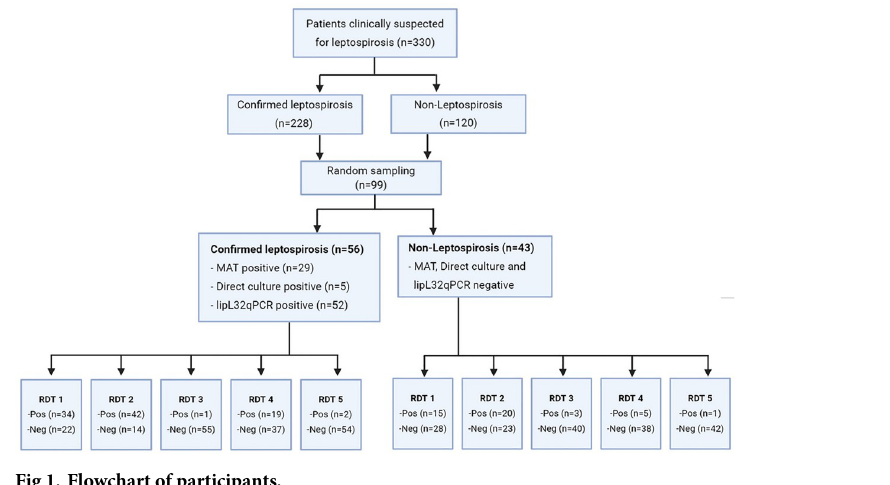
Fig 1. Flowchart of participants.